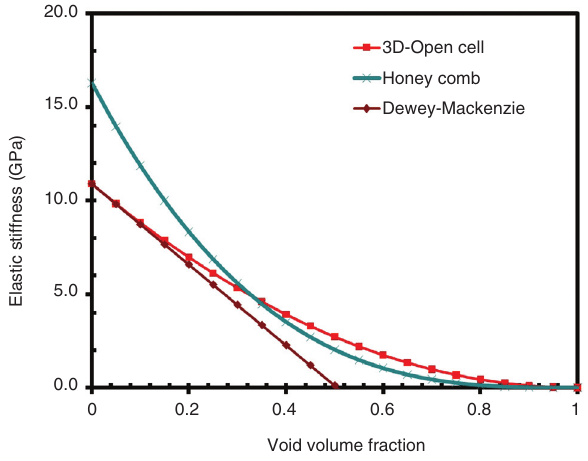
Figure 8 Variation of elastic modulus of nanotube-reinforced PVA scaffold with void volume fractions